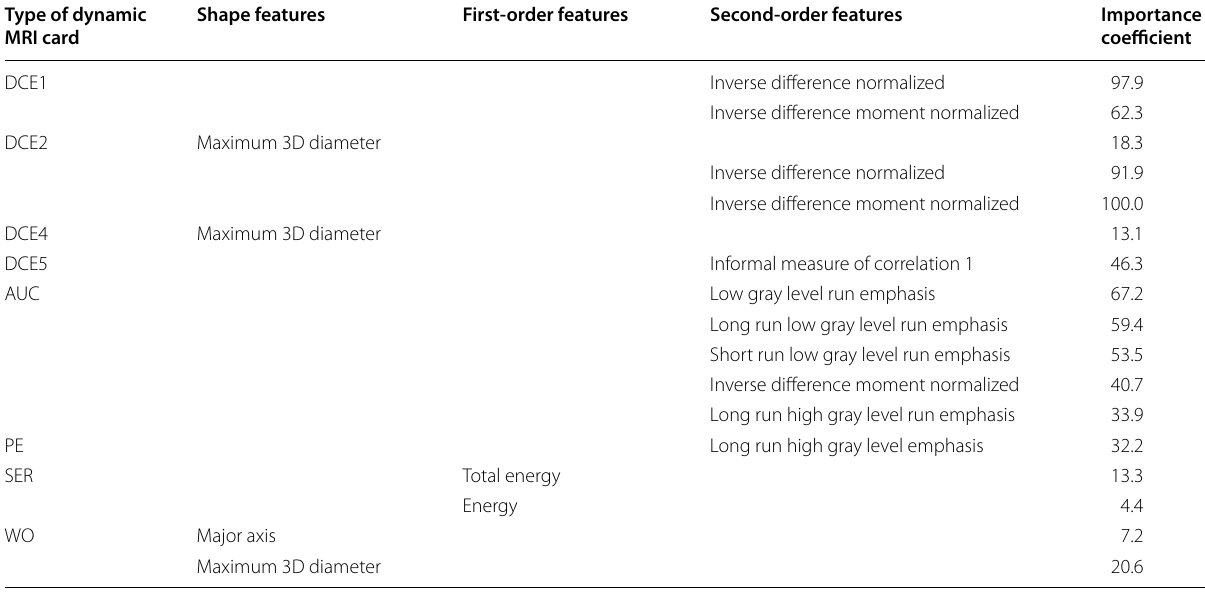
Table 2 Descriptors retained for the creation of the model to predict malignant or benign masses